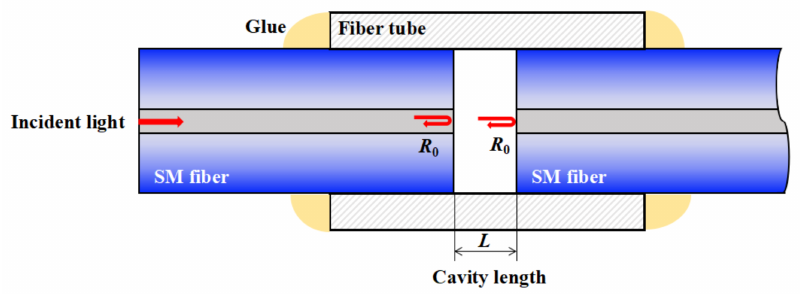
Figure 1. Typical structure of an extrinsic fiber Fabry–Perot (FP) sensor fabricated with two optical fibers and a short fiber tube. SM is single